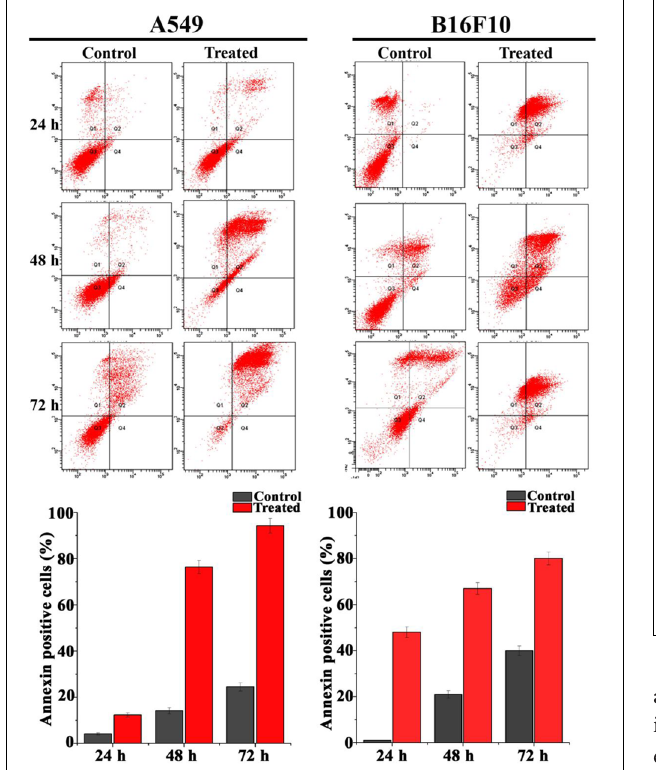
FIGURE 10 | In vitro lymphocyte proliferative activity of Pseudopyronine B after 72 h of incubation period.